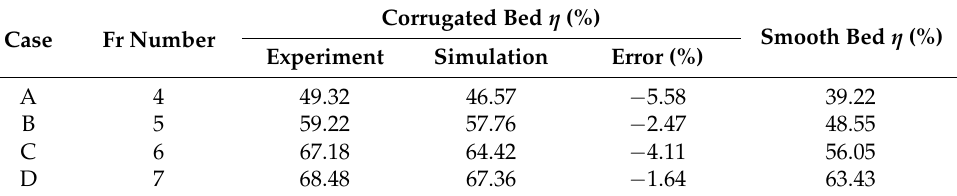
Figure 9. Mean flow velocity of Cases A–F along the channel. Table 6. Energy dissipation rates of Cases A–D.